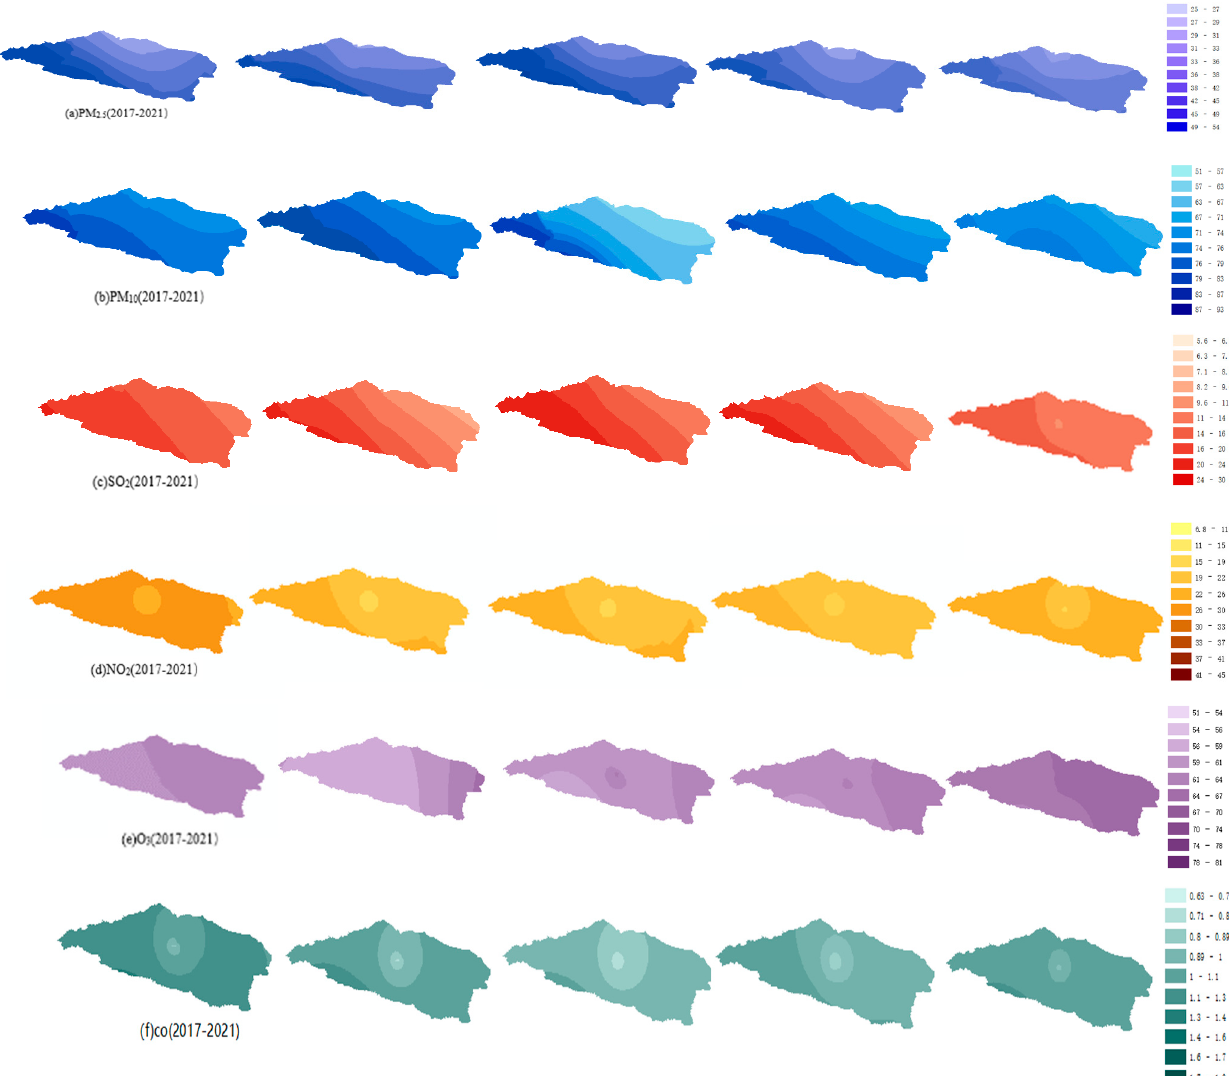
Figure 2. Spatial distribution map of six pollutants in Bozhou from 2017 to 2021 (CO units: mg/m 3 , others are μ g/m 3 ).